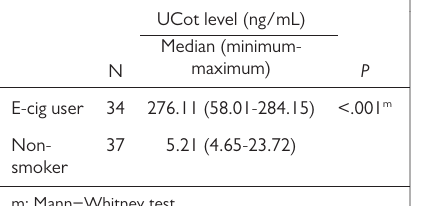
Table 5. UCot and Nicotine Dependence